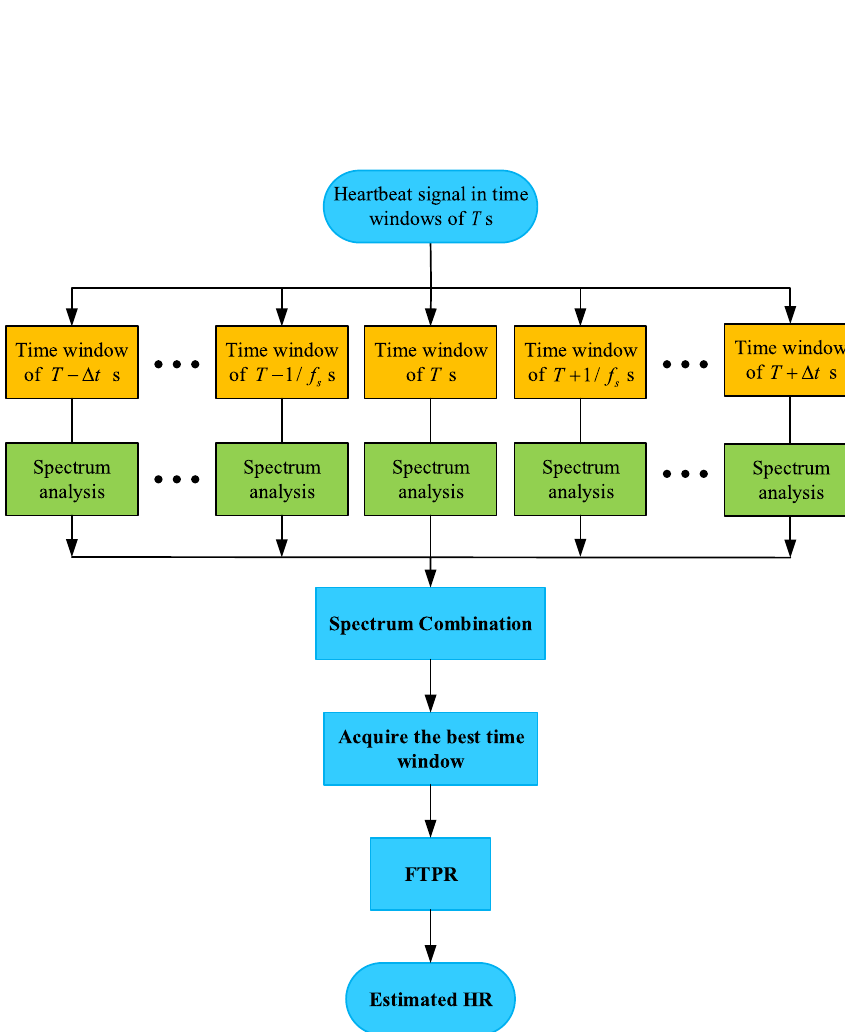
Fig. 6 Flowchart of FTPR-TWV